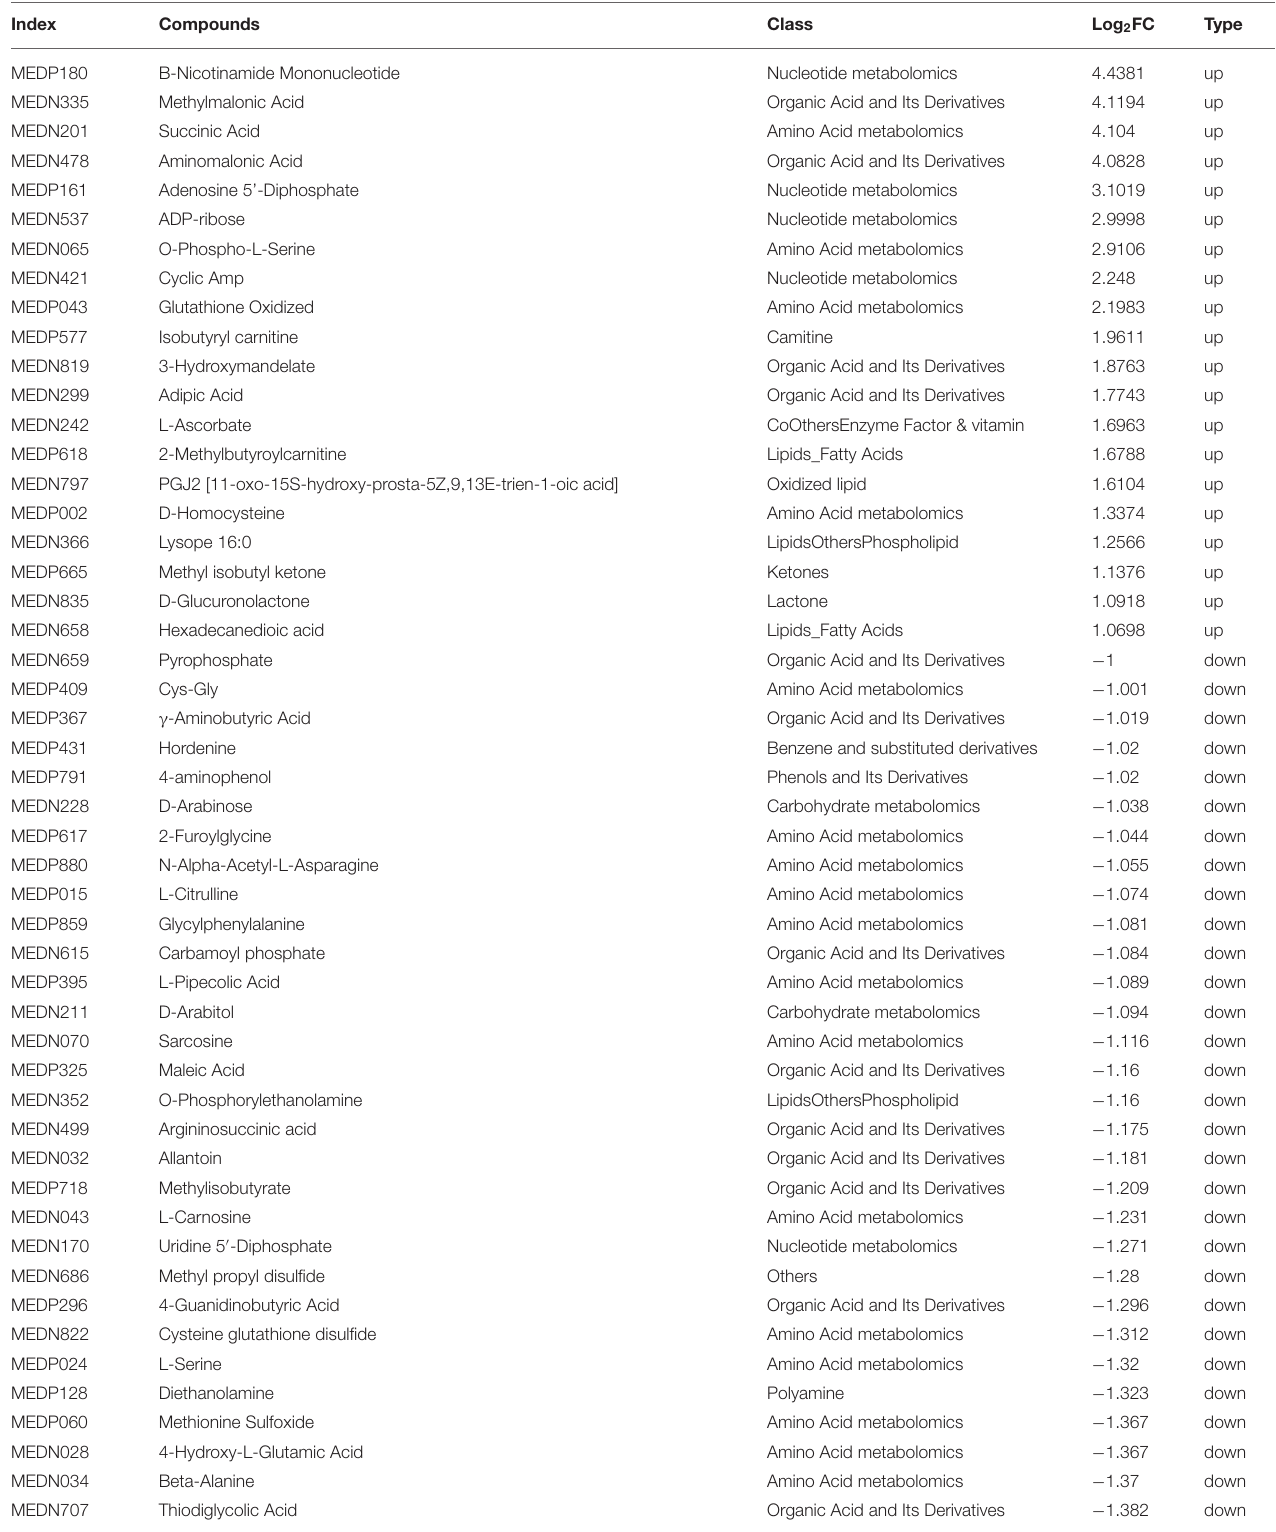
TABLE 3 | Significant metabolites differences in the mouse brain between the high-dose and control